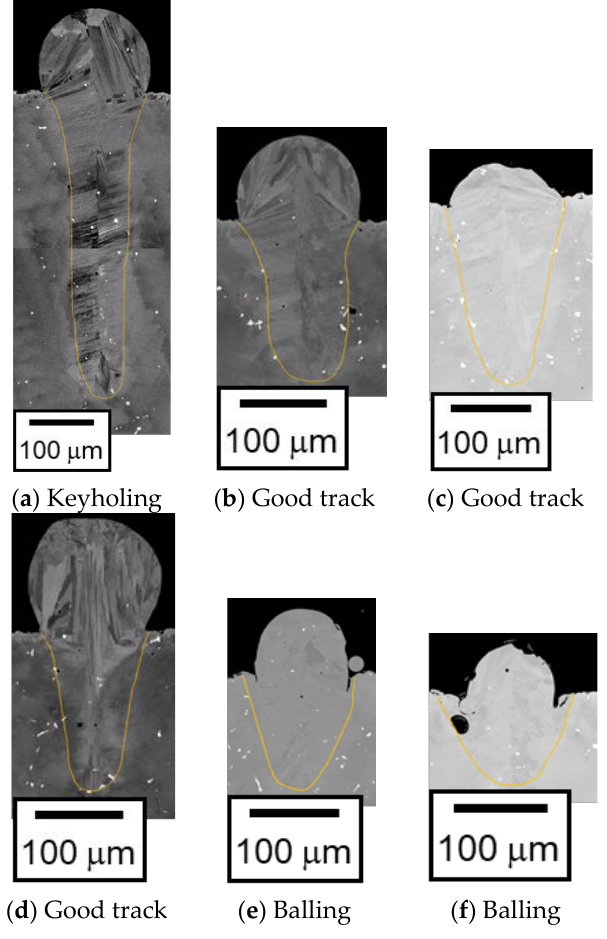
Figure 9. The cross-sectional images in the single-track experiments under P = 500 W and V = 500 ( a ), 900 ( b ), 1000 ( c ), 1100 ( d ), 1500 ( e ), and 2000 ( f ) mm/s.